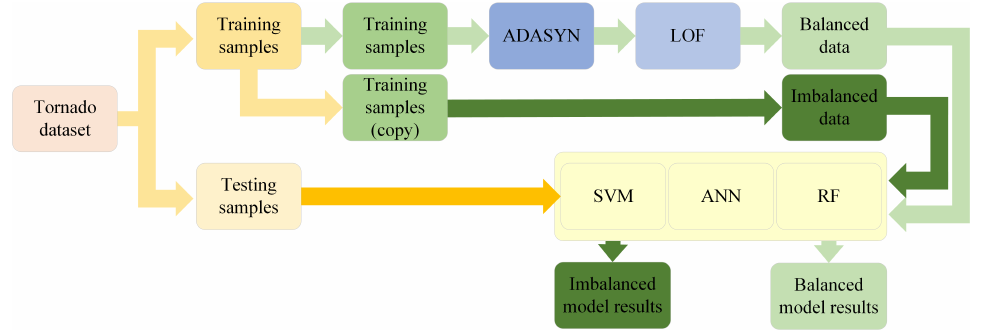
Figure 4. The flow chart of experiment 1. Table 1. Binary classification confusion